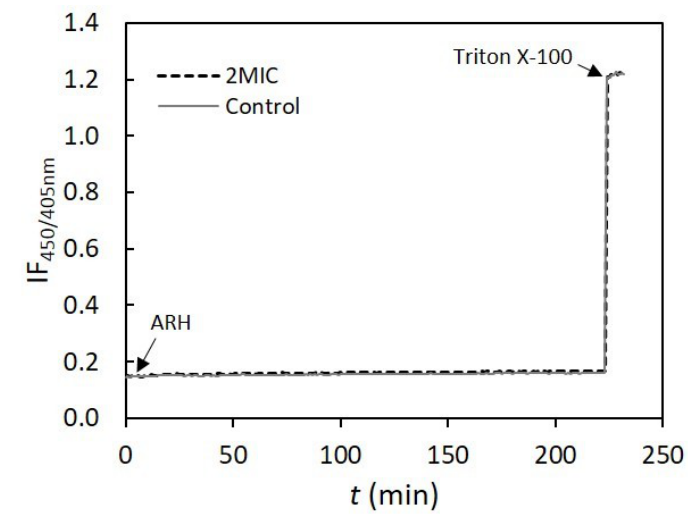
Figure 9. Effect of AHR at 15.6 mg/L (2 MIC, 40 µM) on lipid bilayer passive permeability to protons . Representative curves of the time-dependence of fluorescence intensity ratio of 8-hydroxypyrene-1,3,6-trisulfonic acid (HPTS) at the excitation wavelengths of 405 and 450 nm (IF 450/405 ), at 25 °C. The experiments were conducted with high-cholesterol LUVs at total lipid concentration of 0.2 mM. Triton X-100 (1%) was added at 220 min, to obtain the value of IF 450 / 405 corresponding to total pH gradient dissipation.